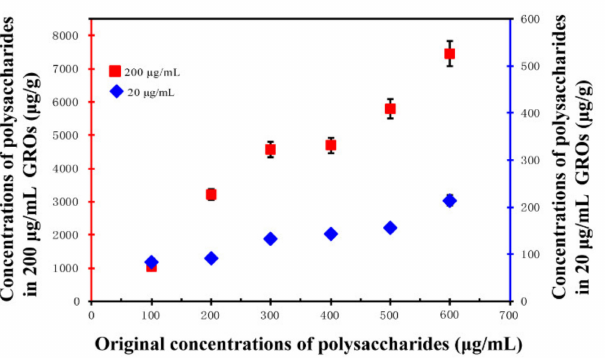
Figure 10. Changes in solid phase concentration of polysaccharides in 20 µ g/mL and 200 µ g/mL GORs (error bars stand for standard